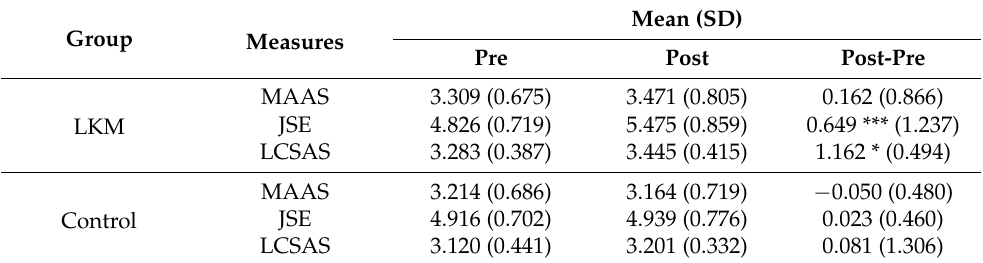
Table 2. Means and standard deviations for each measure of each group, pre- and post-assessment.